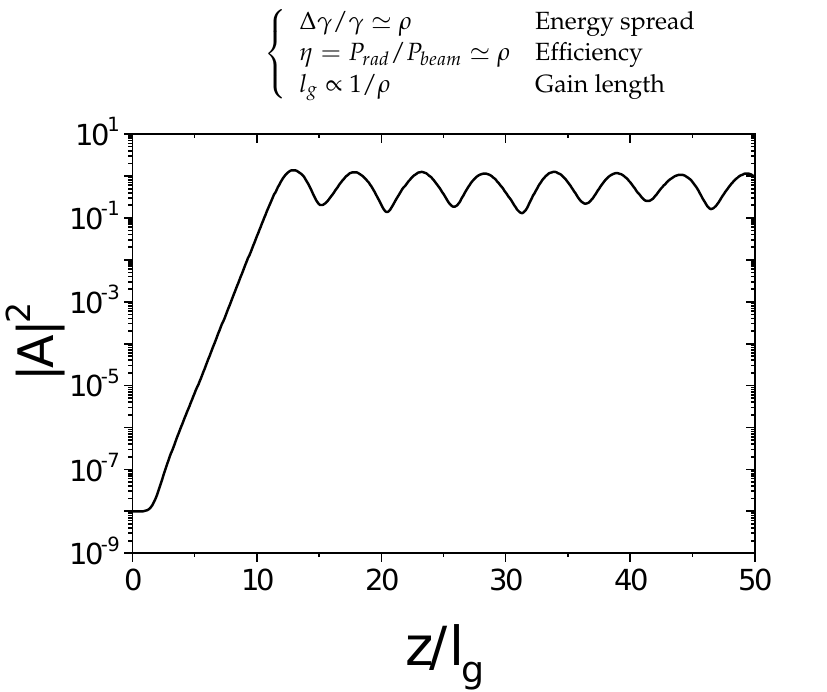
Figure 4. Dimensionless radiation intensity | A | 2 vs. z / l g for δ = 0 and A 0 = 10 − 4